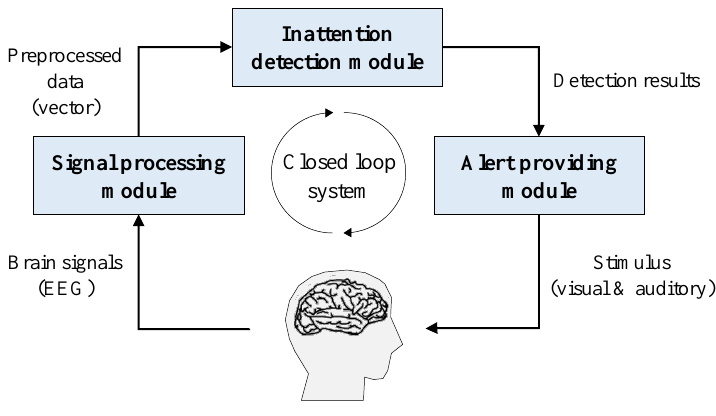
Figure 1. Overview of the proposed attention recovery system for unmanned aerial vehicle (UAV)